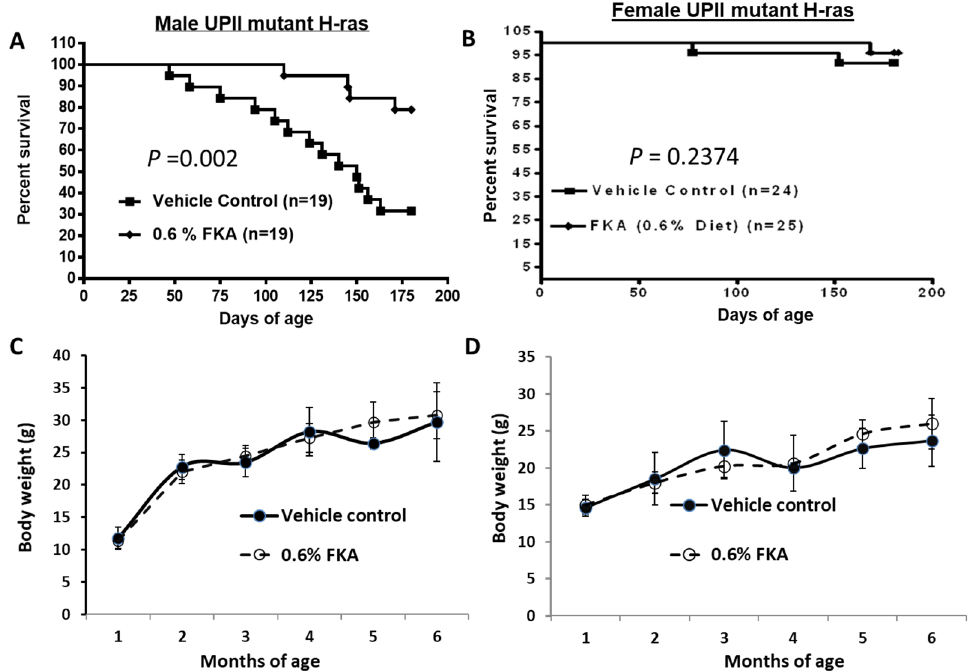
Figure 1. The chemopreventive efficacy of dietary FKA on the survival of UPII-mutant Ha-ras urothelial-tumor-bearing mice. ( A , B ) Male and female UPII-mutant Ha-ras mice were fed daily with control diet and diet containing 0.6% FKA starting at 6 weeks of age until their death or up to 6 months of age. ( C , D ) The mean body weights were recorded and compared every month between male and female mice fed control diet and 0.6% FKA diet.